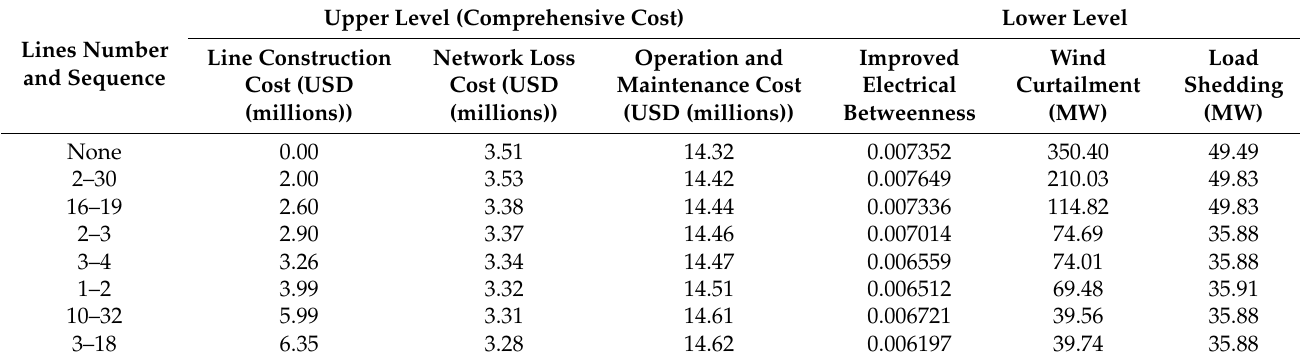
Table 12. TNEP scheme of multi-agent DDQN in modified New England 39-bus system.